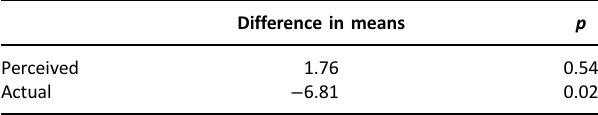
Table 11. Mean grade and instructor gender (male minus